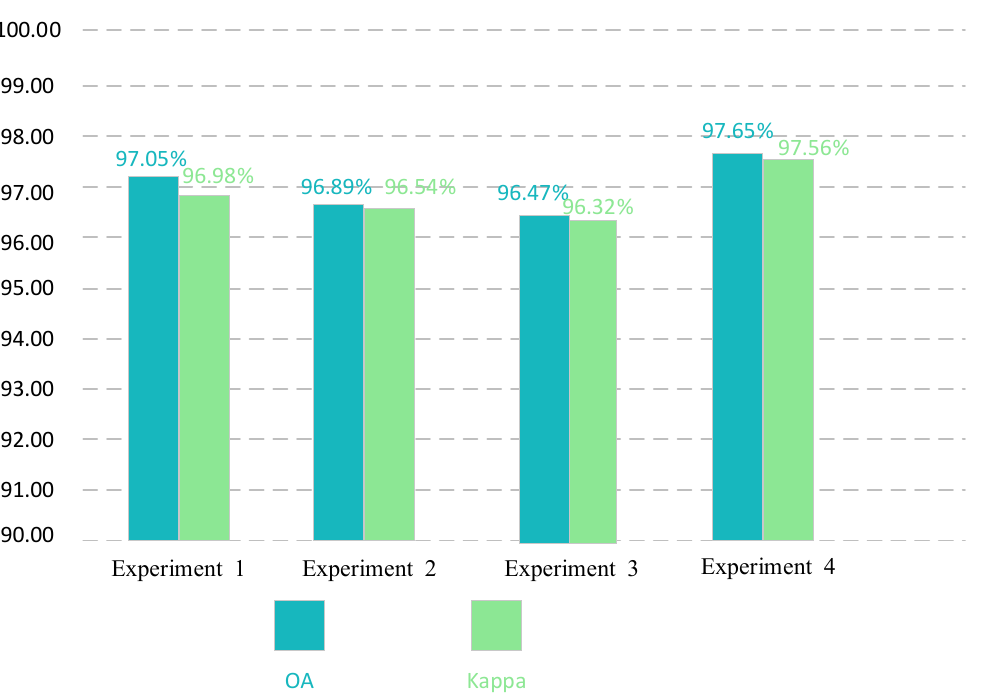
Figure 19. Comparison of OA and kappa values between dimension-wise convolution and traditional convolution on RSSCN dataset with training ratio of 50%.